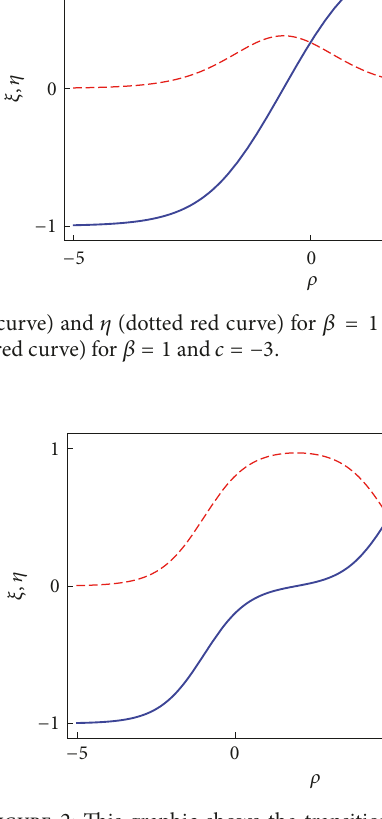
Figure 2: This graphic shows the transition between critical and subcritical solutions. The solutions 𝜉 (solid blue double-kink) and 𝜂 (dotted red curve plateau-like lump) were plotted with 𝛽 = 1 and 𝑐 = −2.001